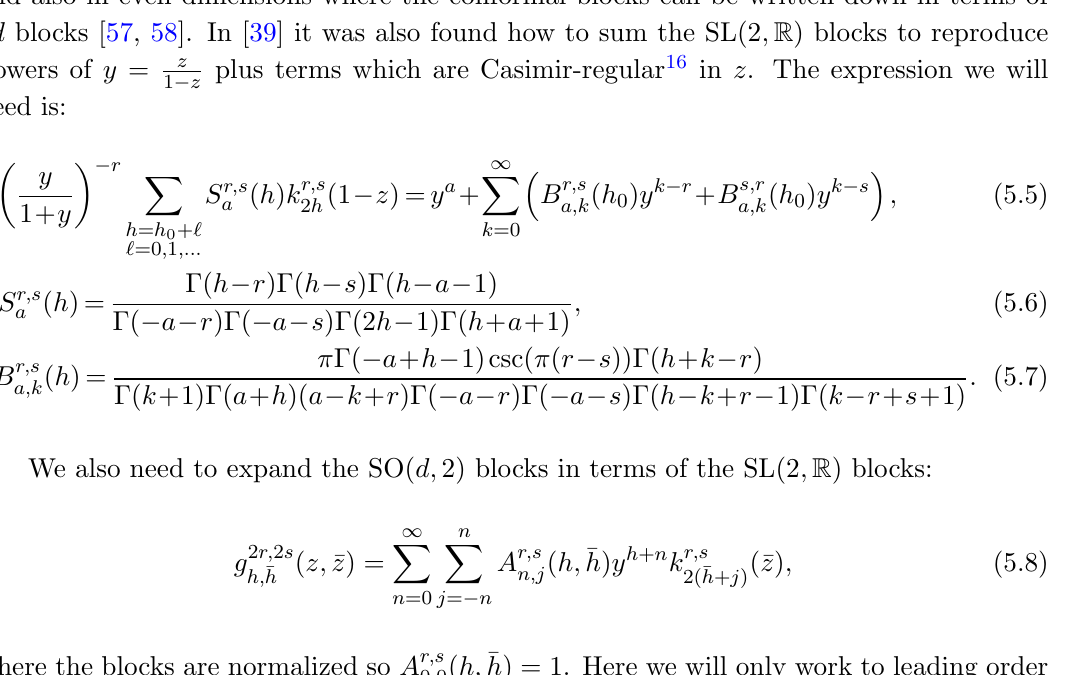
c with isolated operator in t (cid:30)(cid:30) [ (cid:30)(cid:30) ] 0 ;s [ (cid:30)(cid:30) ] 0 ;s